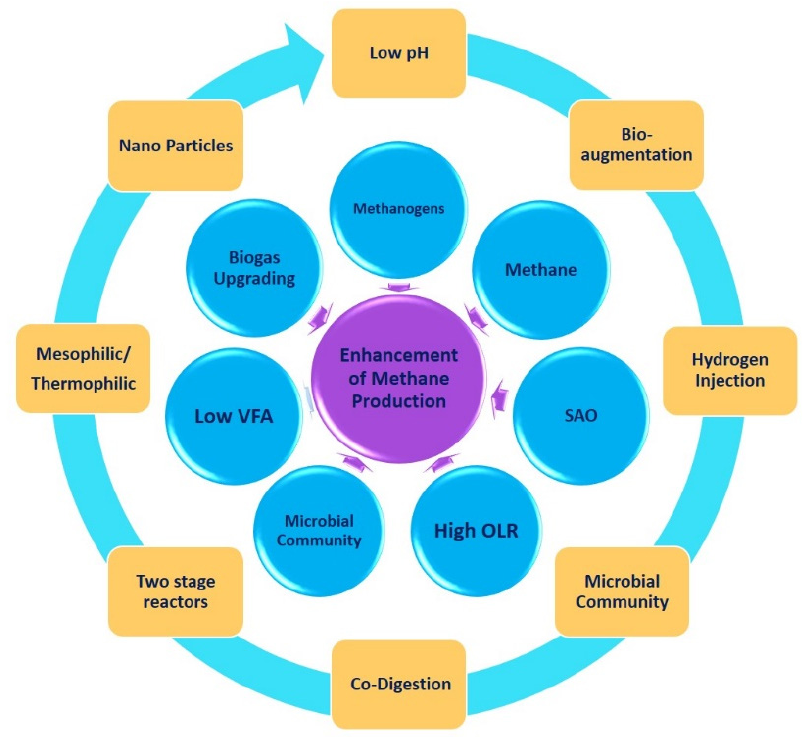
Figure 1. Main factors affecting methane production and used for enhancement of methane